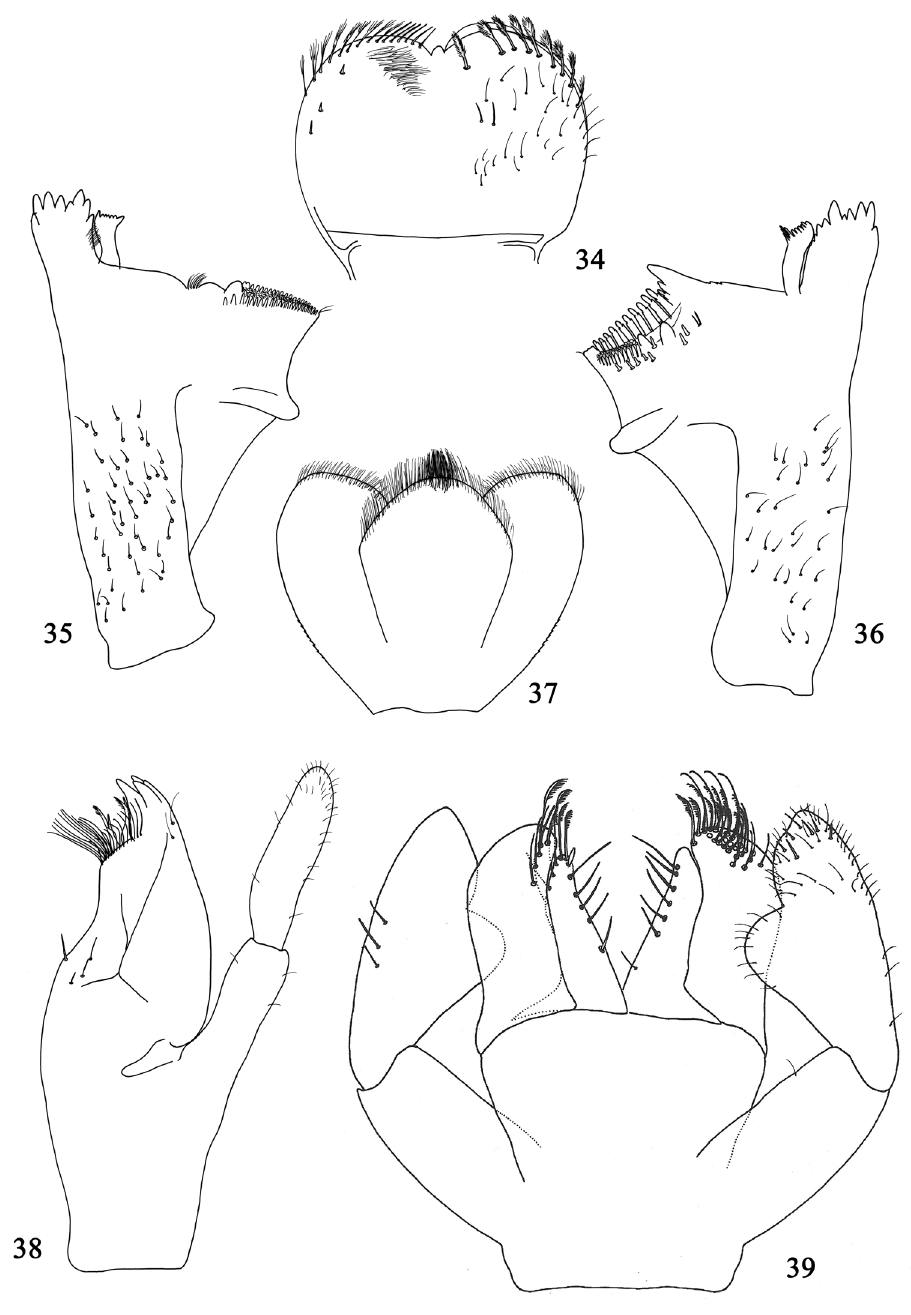
Figures 34–39. Larval structures of Labiobaetis glaucus : 34 labrum (left: ventral; right: dorsal) 35 right mandible 36 left mandible 37 hypopharynx 38 left maxilla 39